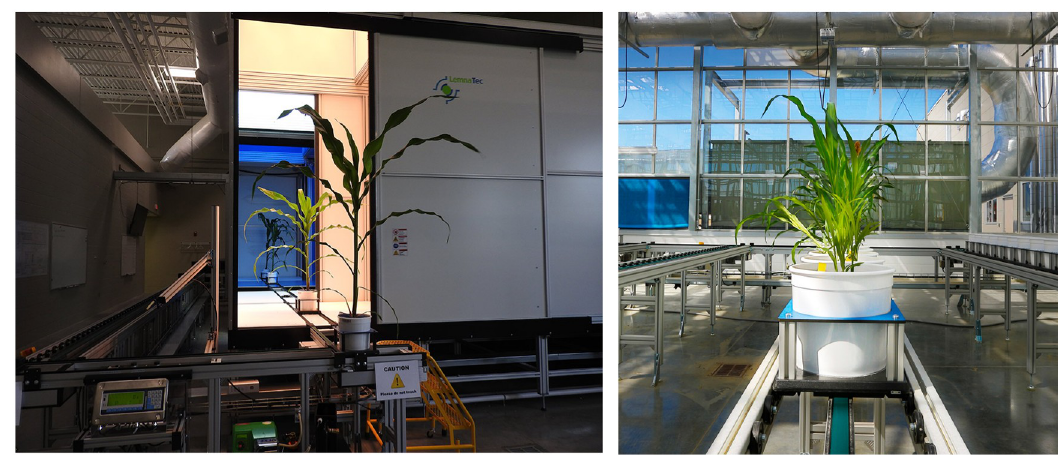
Fig 1. The proposed dataset, CosegPP , was collected using the LemnaTec Scanalyzer 3D plant phenotyping facility located at the University of Nebraska-Lincoln, USA. This facility is meant to create high throughput plant phenotyping datasets. The first image shows plants being imaged with a visible, infrared, fluorescent, and near infrared camera and exiting the LemnaTec chambers. The second image shows a row of plants on a conveyer belt in the greenhouse located next to the LemnaTec chamber.